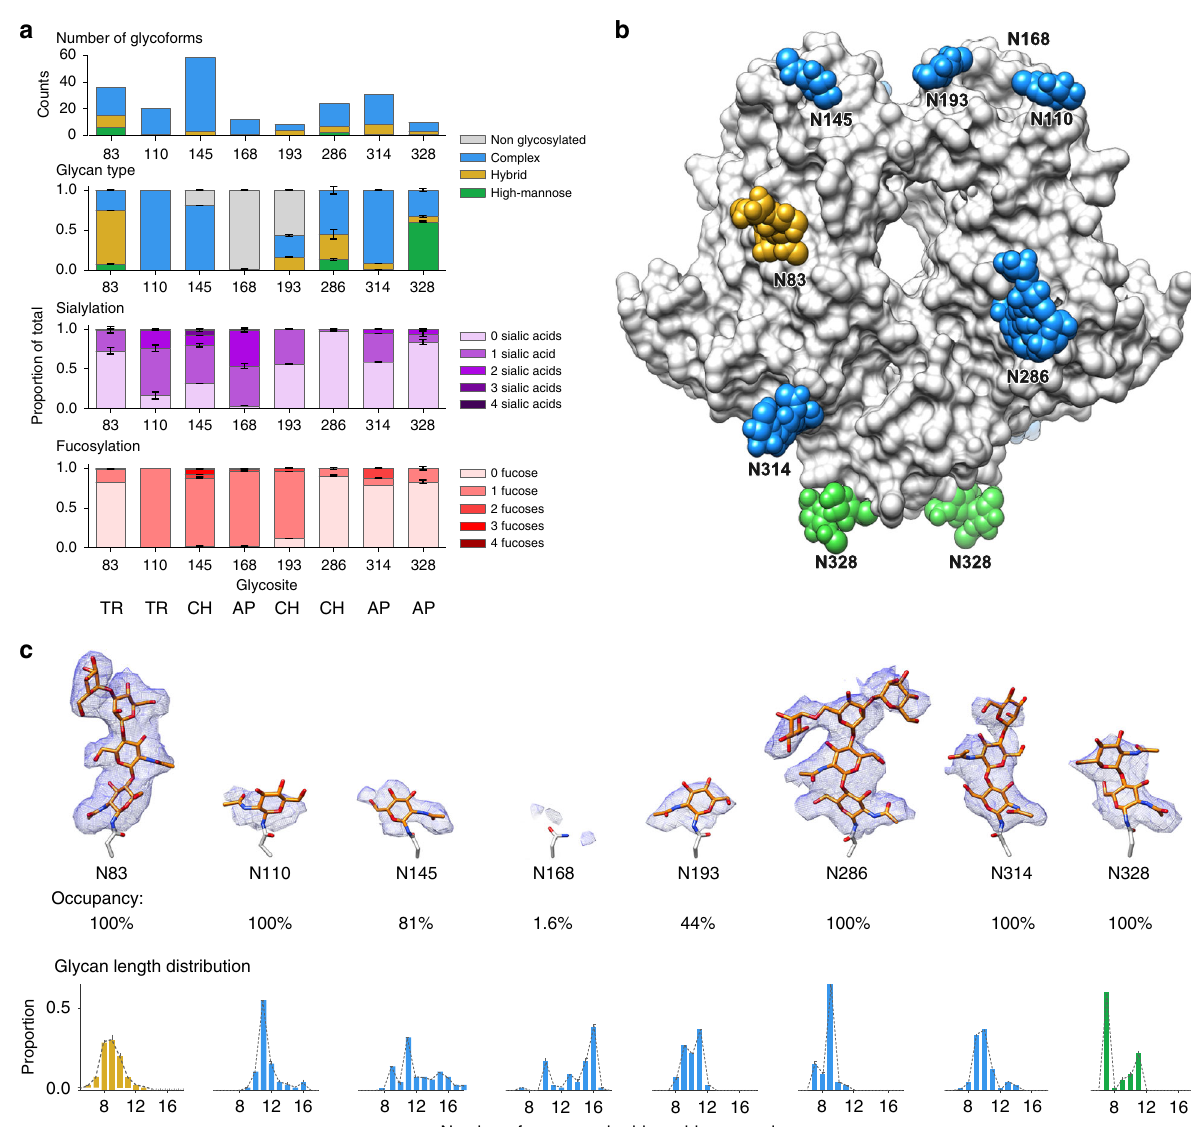
Fig. 3 N-glycosylation of HKU1 HE. a Glycoproteomic analysis of N -linked glycosylation in HKU1 HE. Top panel enumerates the total of unique glycan compositions identi fi ed per site. Bottom three panels show semiquantitative analyses from extracted peak areas of site-speci fi c N -glycosylation by glycan type (non-glycosylated, high-mannose, hybrid, or complex), fucosylation, and sialylation. Error bars represent the standard deviation of the duplicate measurement. The selected protease dataset from which the data was extracted is indicated for each site: TR trypsin, CH chymotrypsin, AP alpha-lytic protease. A full overview is presented in Supplementary Fig. 9 and Supplementary Data 1. b Surface representation of the dimeric HKU1 HE atomic model, with modelled N -glycans shown as spheres and coloured according to the predominant glycan type shown in ( a ). c EM density (blue mesh) zoned 2 Å around each of the modelled N -glycans and analogous region for N168. The occupancy and glycan length distribution from glycoproteomics analysis for each site is shown